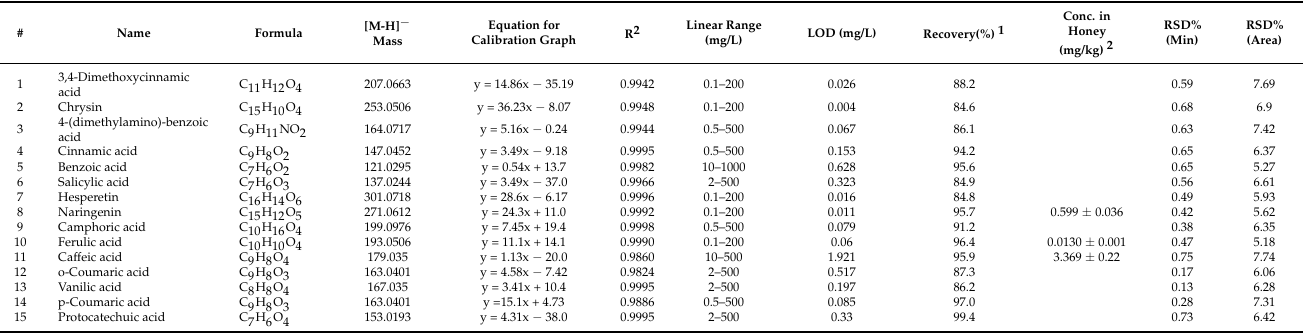
Table 1. Analytical Performance Data of CZE-MS